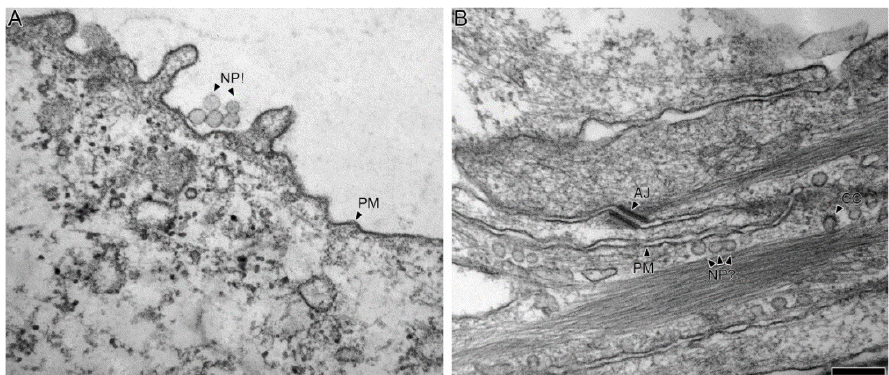
Figure 7. PS NPs imaged with a conventional transmission electron microscope. This image shows the difficulty of distinguishing clearly between NPs ( A ) and cellular structures ( B ) using standard transmission electron microscopy. CC stands for clathrin coated vesicle; PM is for plasma membrane; and AJ stands for adherens junction. Ref [74] Reproduced with permission from Mühlfeld et al., Particle and Fibre Toxicology; published by BioMed Central, 2007.